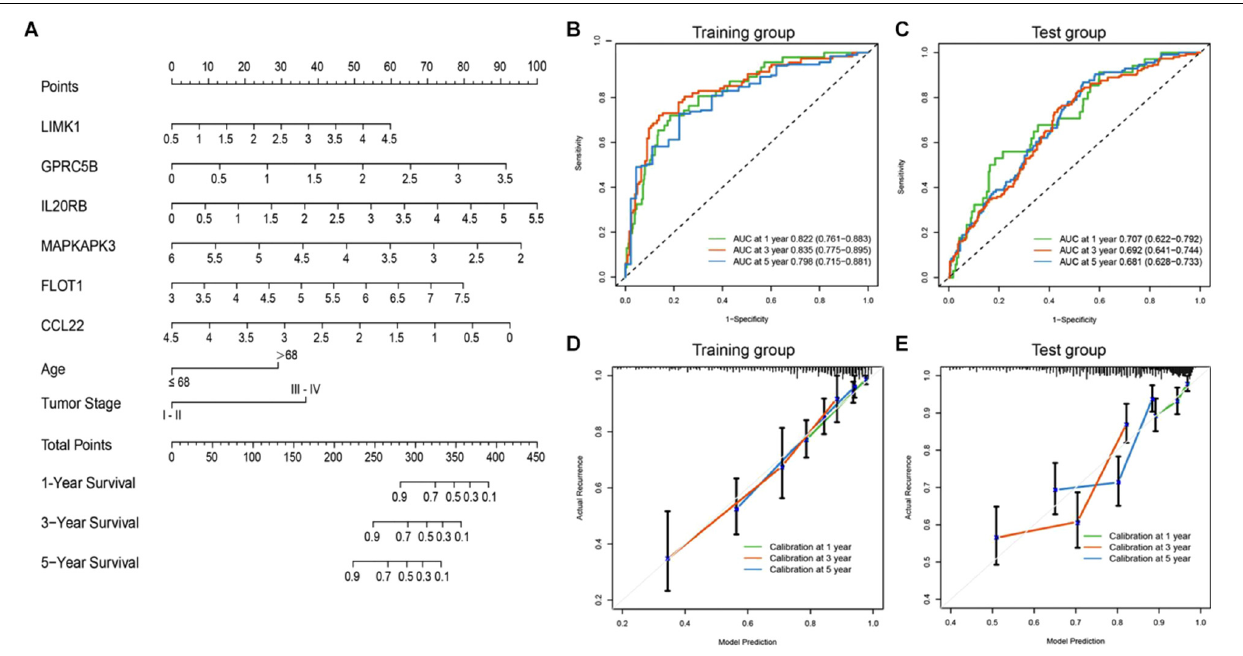
FIGURE 5 | Nomogram incorporating clinical factors and IRG signatures. (A) A predictive nomogram was constructed using clinical risk factors and the designated IRG panel, via which patients’ 1, 3, and 5 years survival could be predicted. (B,C) Time-ROC curves of the nomogram in large ( n > 400) independent database (TCGA and GSE39582). The AUC values were consistent at different time points. (D,E) Calibration curves were plotted to reveal the concordance between prediction and reality. In both the training and validation sets, the model showed good calibration.